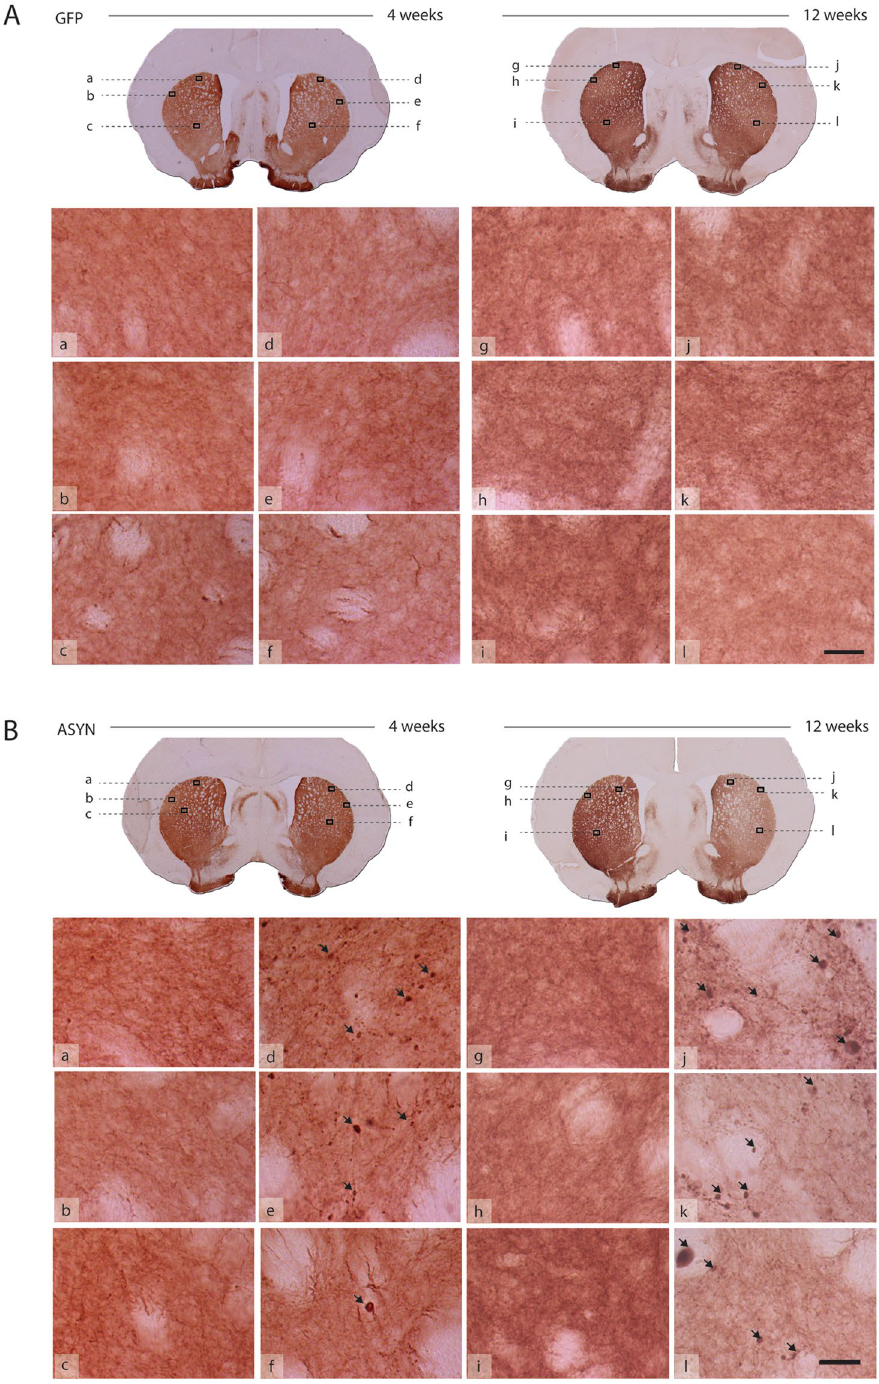
Figure 7. Pathology in striatal fibers. TH immunostained striatal sections from GFP ( A ) and ASYN animals ( B ) processed for histology at 4 weeks (left; a–f) or 12 weeks (right; g–l) post-surgery. Each section showed in low magnification in the upper row. Several high-power images are presented to reveal details of the fibers. GFP controls display healthy fibers of homogenous morphology in both striata at all time points ( A ). Notably, ASYN animals exhibit pathological TH + formations (arrows) in the injected side at 4 weeks ( B ; d–f) and more severe pathology was observed later at 12 weeks ( B ; j–l; arrows). In comparison, the contralateral non-injected side displays homogenous distribution with no pathology ( B ; a–c and B ; g–i), which was similar to the healthy morphology found in GFP controls. Scale bar = 30 µ m applies to all high magnification